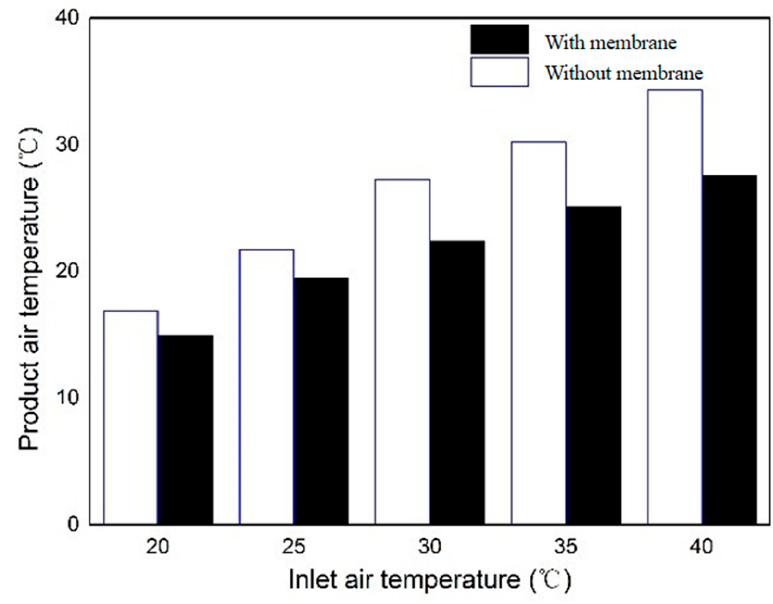
Figure 8. Product air temperature under various inlet air temperature conditions.